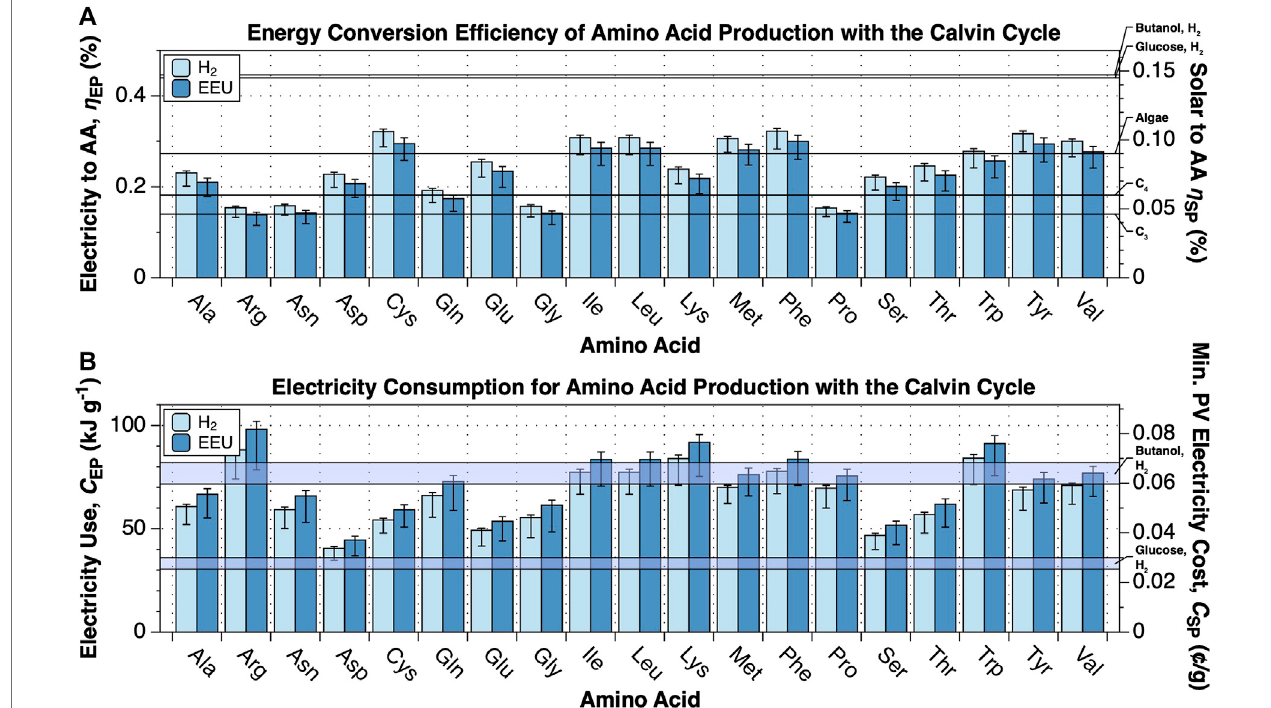
FIGURE 2 | Energy conversion ef fi ciency and energy cost of amino acid production. The upper limit energy conversion ef fi ciency and minimum energy cost of aminoacidproductionfromCO 2 ,N 2 andelectricitybyelectromicrobialproductionsystemsusingtheCalvincycleforCO 2 - fi xationandeitherH 2 -oxidationorextracellular electron uptake (EEU) were calculated for 19 dietary amino acids (all except histidine) with the electrofoods package (Barstow, 2021). NADH, Fdred, and ATP requirements for synthesis of each amino acid are tabulated in Supplementary Dataset S2 . This plot can be reproduced using the fi g- cbb_n2_to_amino_acids.py program in the electrofoods package (Barstow, 2021). (A) Upper limit electrical and solar energy conversion ef fi ciency for amino acids. The left axis shows the electricity toamino acid energy conversion ef fi ciency, while the right axis shows the solar to amino acid conversion ef fi ciency, assuming the system is supplied by a perfectly ef fi cient single-junction Si solar photovoltaic (solar to electrical ef fi ciency of 32.9% (Nelson, 2003)). As a fi rst point of comparison, the upper limit solar to biomass energy conversion ef fi ciencies of C3, C4 (Zhu et al., 2008; Zhu et al., 2010), and algal photosynthesis (Wijffels and Barbosa, 2010) are marked on the right axis. As a second point of comparison, we have also marked the projected upper limit solar to butanol (Salimijazi et al., 2020) and glucose (calculated